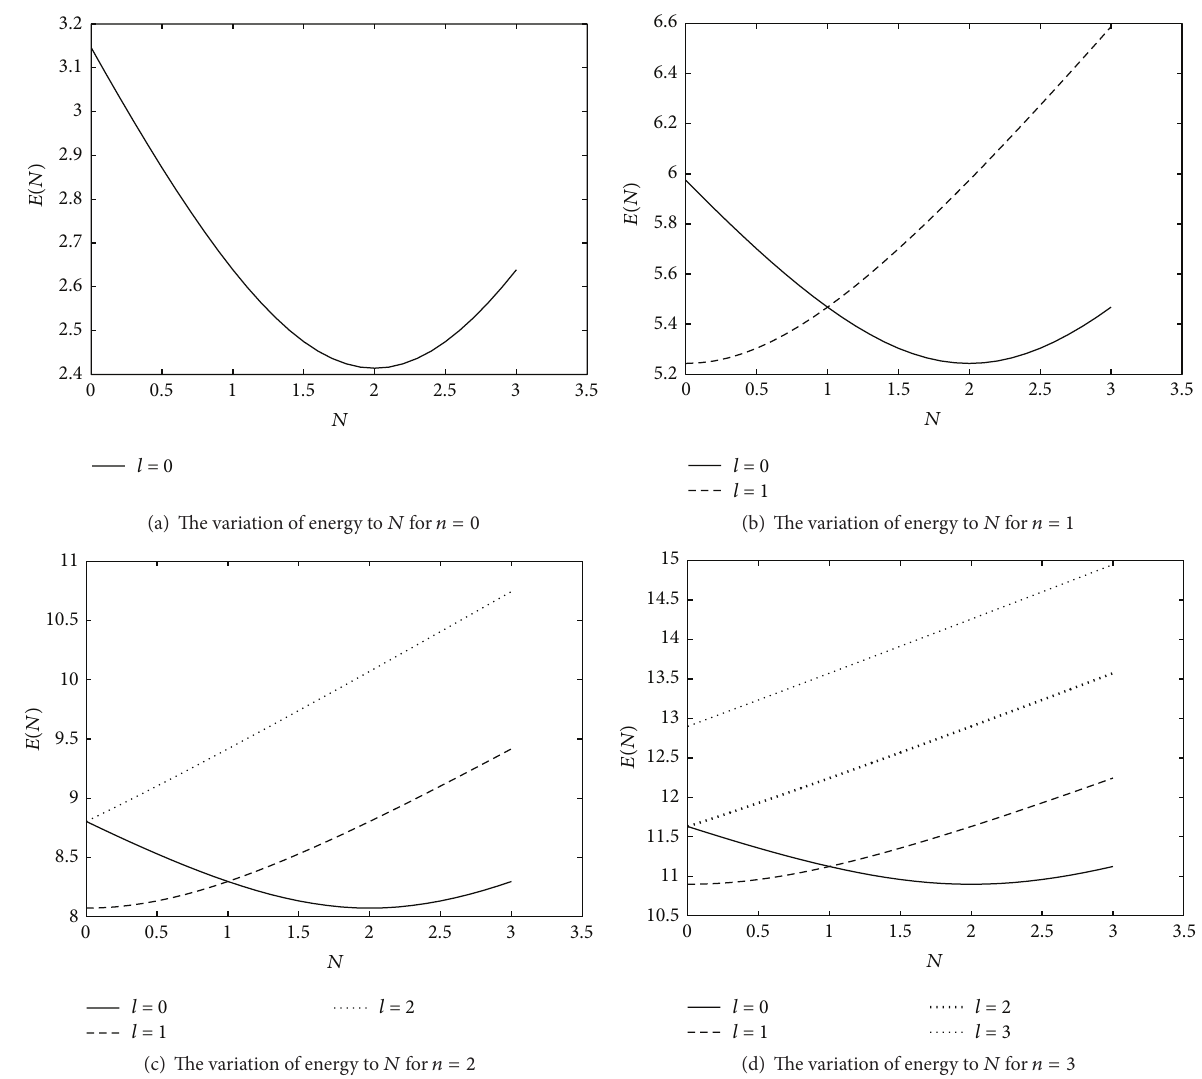
Figure 1: The dependence of 𝐸(𝑁) on 𝑁 . Parameters: 2𝑀 = 1 , ℏ = 1 , and 𝑎 1 = 𝑎 2 = 0.5